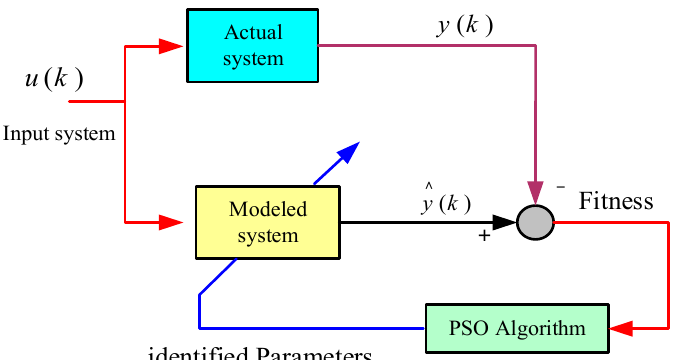
Figure 2. Block diagram of Particle Swarm Optimization (PSO) identification algorithm.